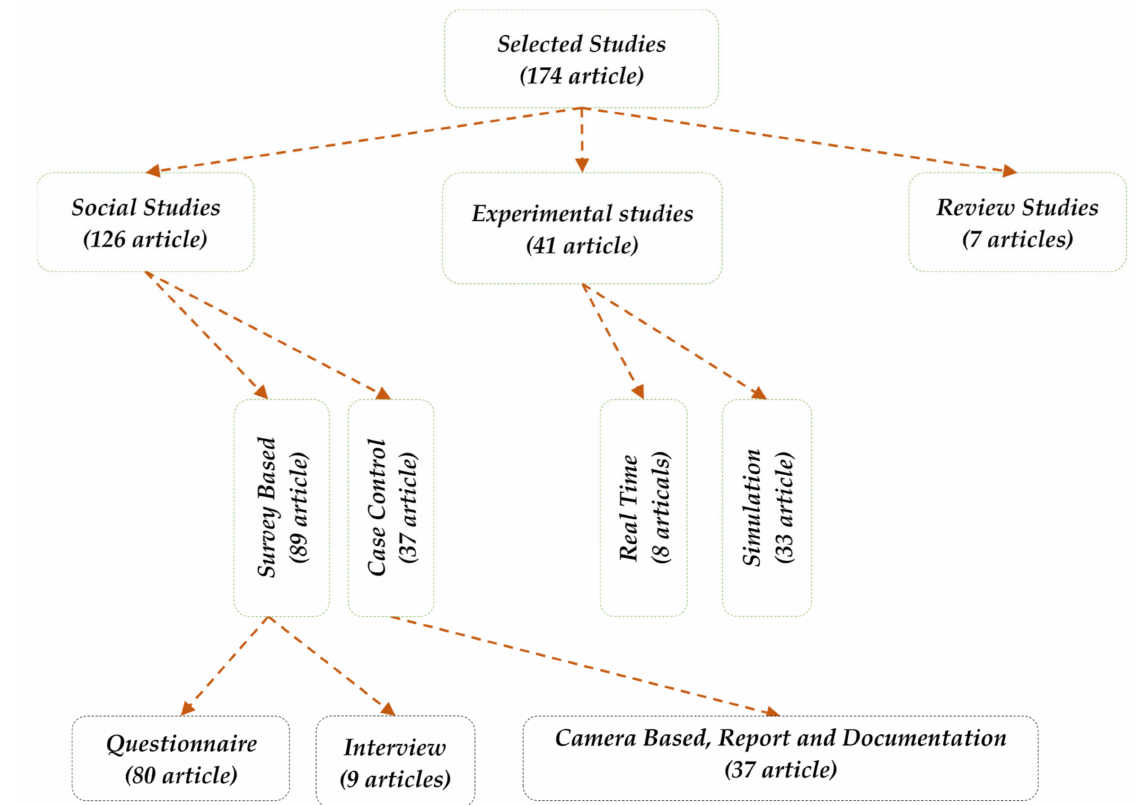
Figure 3. Taxonomy of research literature on motorcycle drivers’